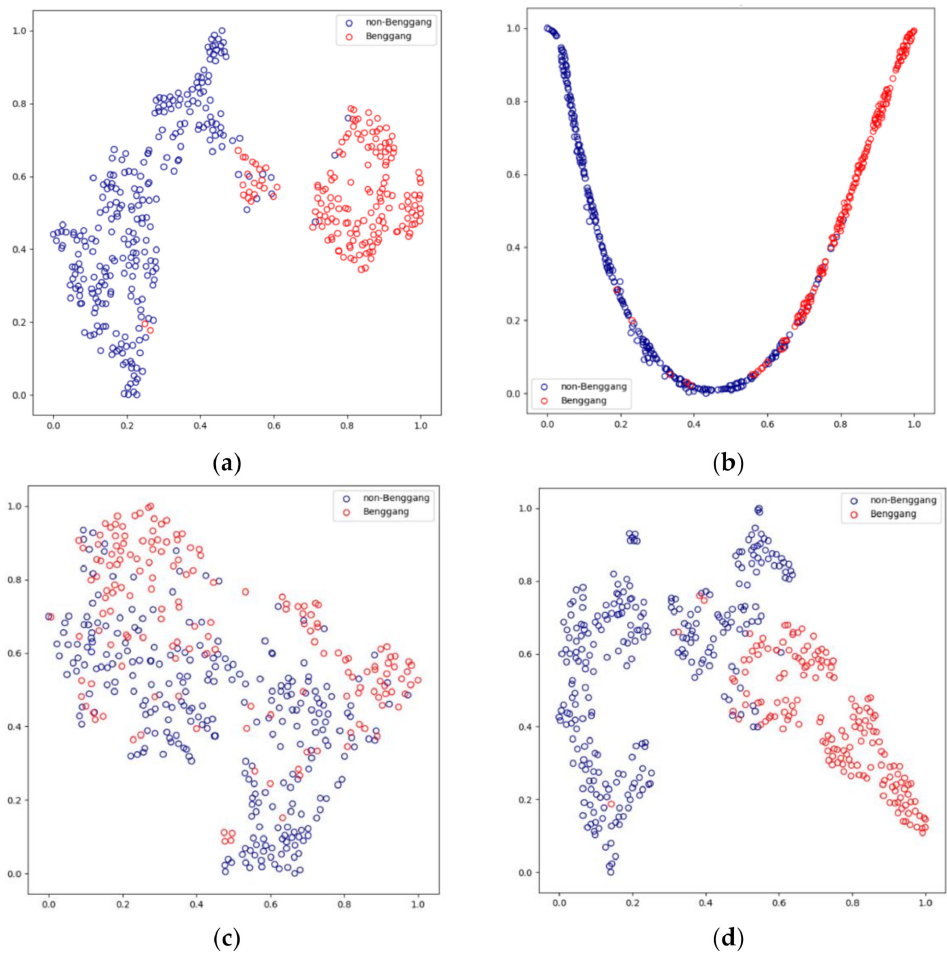
Figure 7. Visualization of feature embeddings for each grid cell using t-SNE for area 1 in dataset 1. ( a ) Our deep fusion approach. ( b ) VGG-DOM. ( c ) DCNN-DSM. ( d )